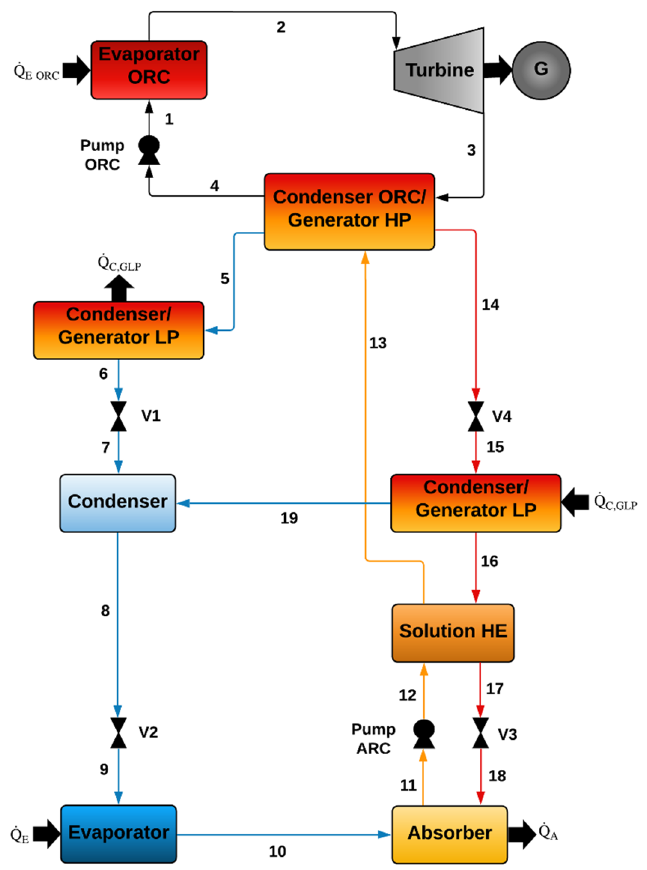
Figure 1. Schematic diagram of the proposed system.